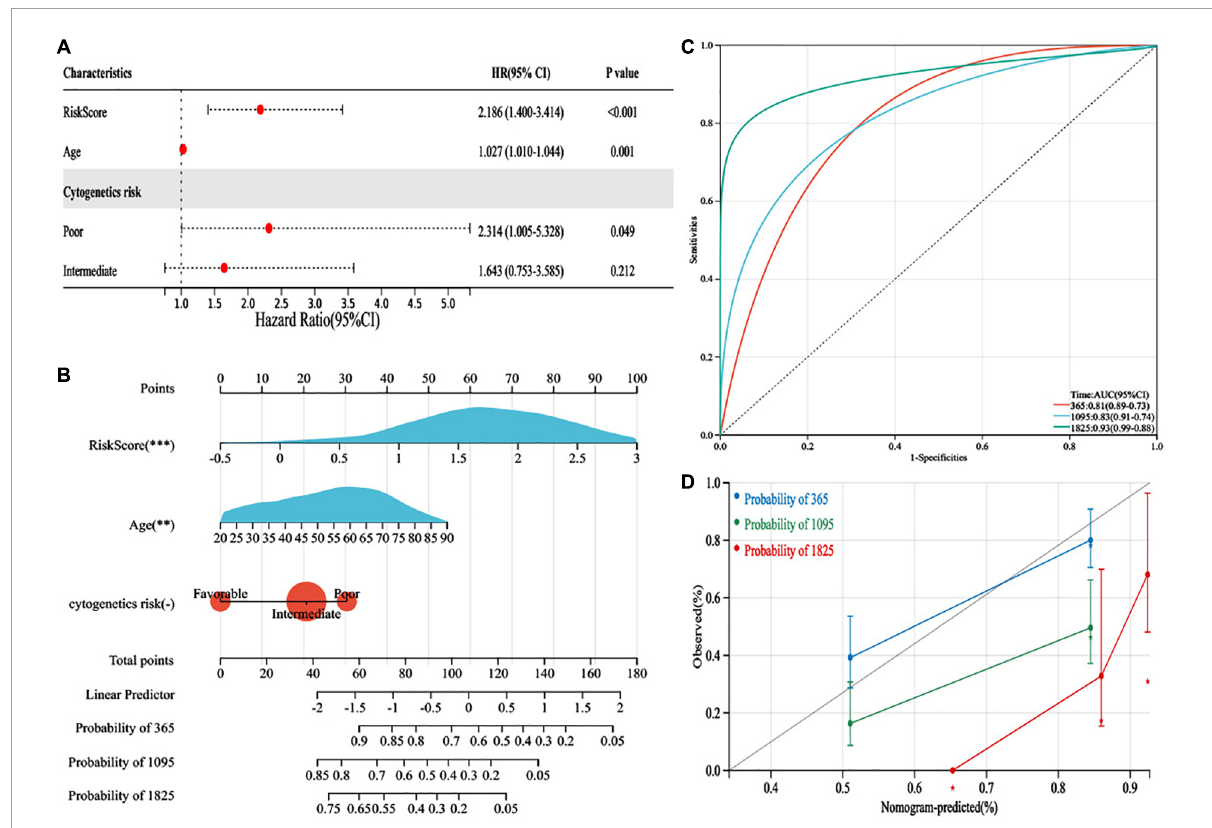
FIGURE6 Development of a predictive nomogram in the cancer genome atlas (TCGA) datasets. (A) The multivariate cox regression analysis validated independent prognostic factors in TCGA database. (B) Development of nomogram based on risk score, age, and cytogenetic risk in TCGA database. (C) The performance of the nomogram was assessed by receiver operating characteristic (ROC) curves for 1, 3, and 5 years. (D) Calibration curves for 1-, 3-, and 5-year prediction. ∗ p < 0.05, ∗∗ p < 0.01, ∗∗∗ p < 0.001, ns, no